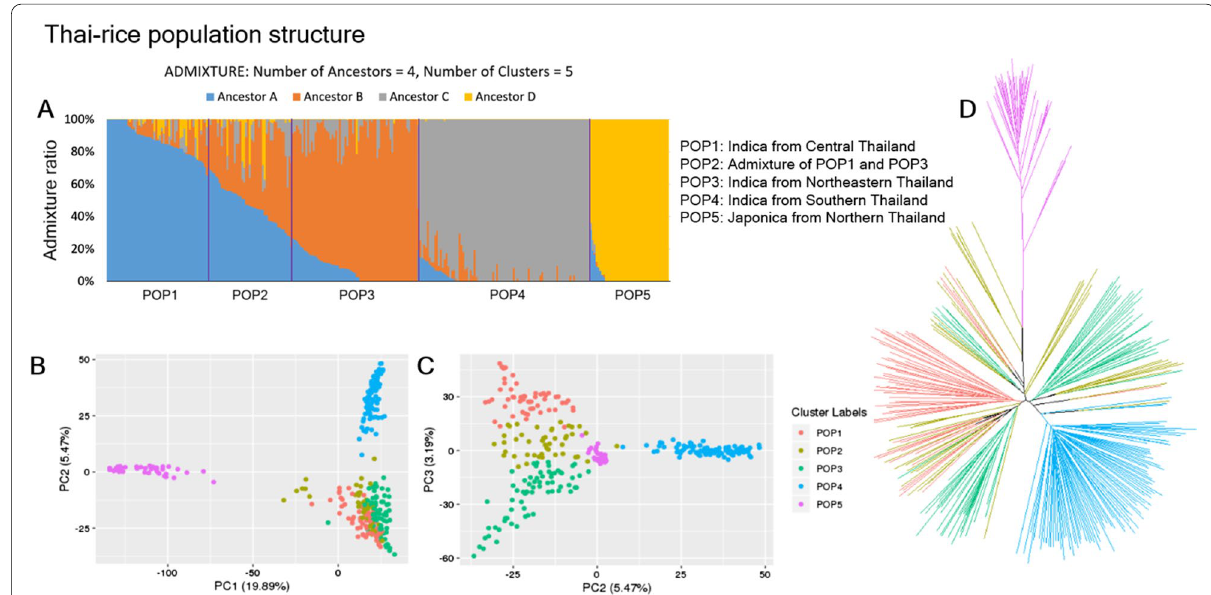
Fig. 2 Population structure of 300 rice accessions inferred from 69,777 SNPs and 47,277 Indels. A Admixture plot of 300 rice accessions. The vertical axis represents an ancestry ratio of each accession. The horizontal axis represents individual accessions grouped by clustering analysis. Groups were assigned by clustering analysis on individual-admixture ratios. There are four ancestors (ancestor A–ancestor D) with five populations (POP1–POP5) inferred by clustering analysis. B The PCA scatter plot of first and second principal components (PCs) from a principal component analysis. C The PCA scatter plot of second and third PCs. Cluster colors were assigned according to ADMIXTURE clustering analysis results. The PC1 separates the japonica accessions (POP5) from the indica accessions. PC2 separates southern indica accessions (POP4) from central and northern accessions (POP1, POP2, and POP3). Lastly, PC3 separates central indica (POP1), from northern indica (POP3) with their admixture accessions appearing in